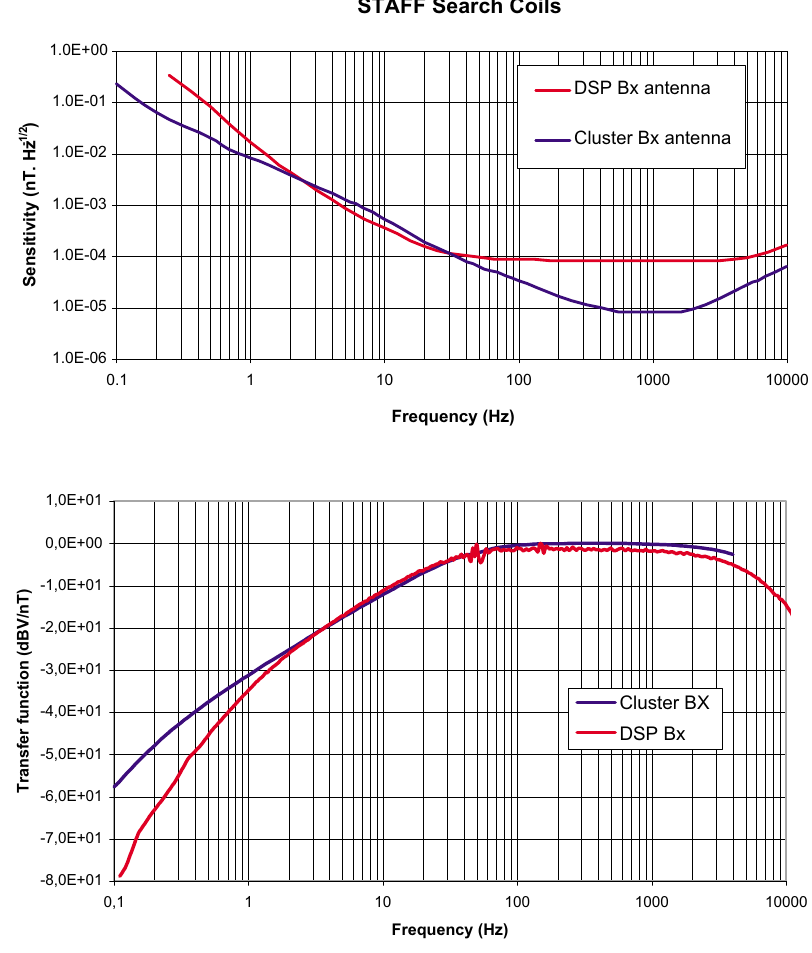
Fig. 3. The DSP TC1 sensitivity and transfer function of the B x component of the triaxial search coils of the STAFF experiment in red. For comparison the same for Cluster is drawn in blue. A filtering at the spin frequency has been added at the input of DSP preamplifiers, to take into account the strongest field at perigee, with respect to